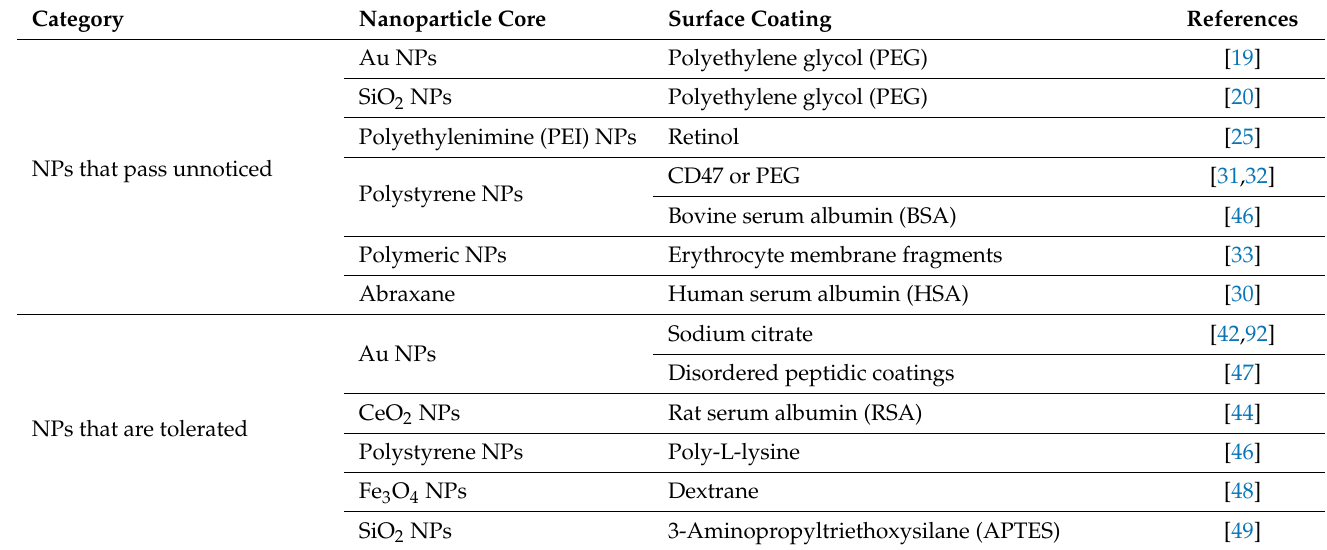
Table 3. Immune responses to NP